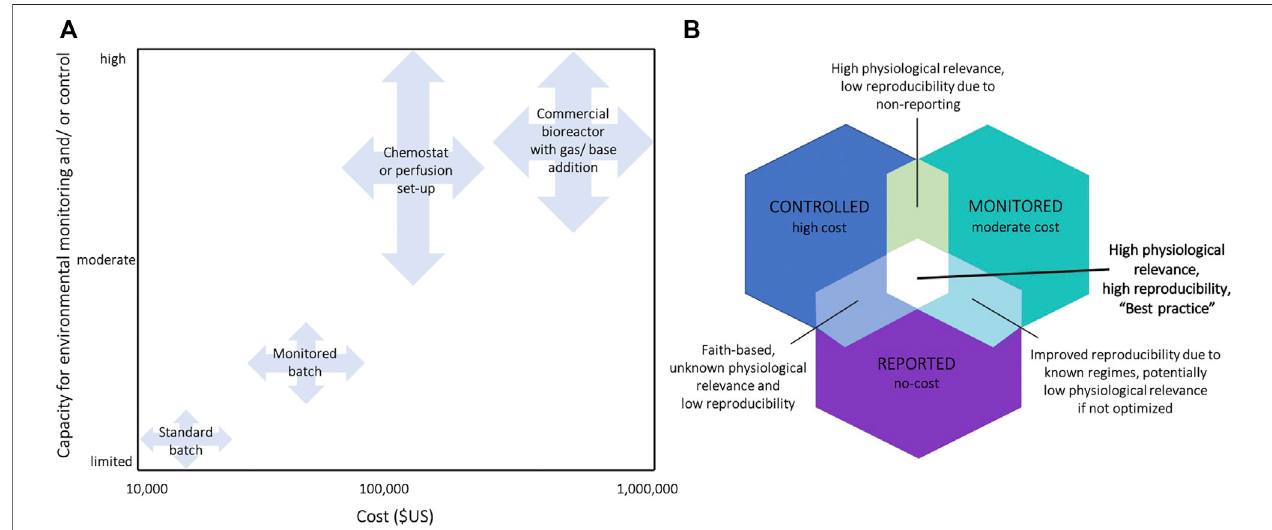
FIGURE 3 | (A) Classi fi cation of cell culture systems by their capacity for environmental control/and or monitoring, and estimates of the required fi nancial investments. Estimates for the required fi nancial investment include the full costs associated with the required set-ups, including the key infrastructure required (see Supplementary Table S2 for prices of exemplary commercial systems) (B) Venn diagram summarizing the bene fi ts and disadvantages of monitoring, controlling, and/ or reporting cell culture environments in experiments. E.g., acquirement of a bioreactor is high in cost, but often only setpoints are reported without actually measuring environmental conditions in the medium (mean ± SE) leading to unknown physiological relevance and low reproducibility.